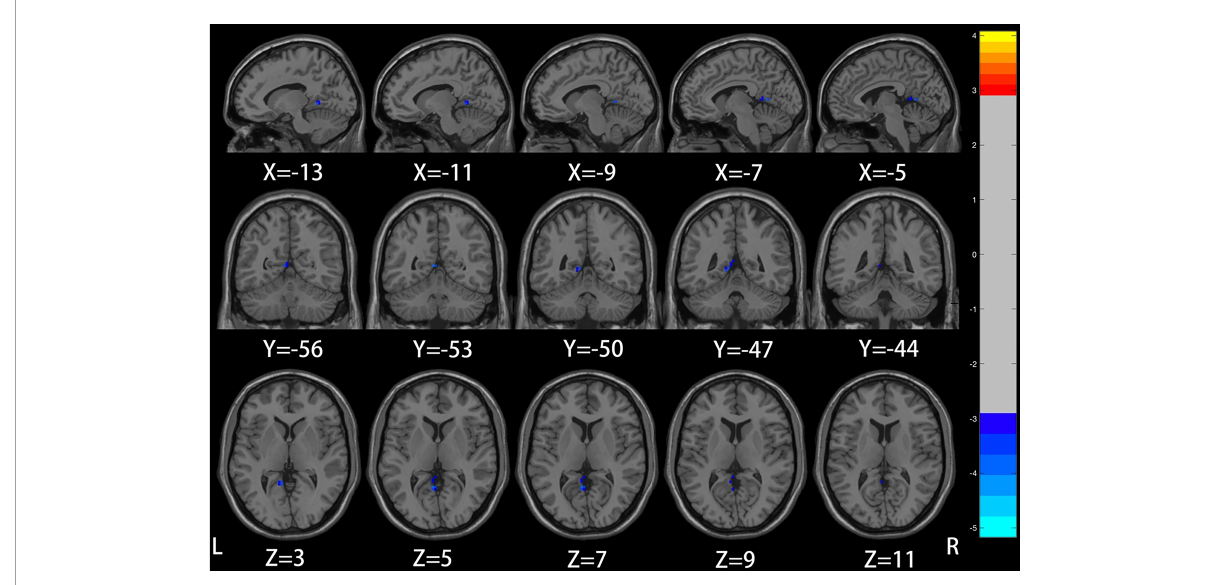
FIGURE1 Compared to healthy controls, the region of reduced mALFF in mild to moderate depression patients was located in the left precuneus /posterior cingulate